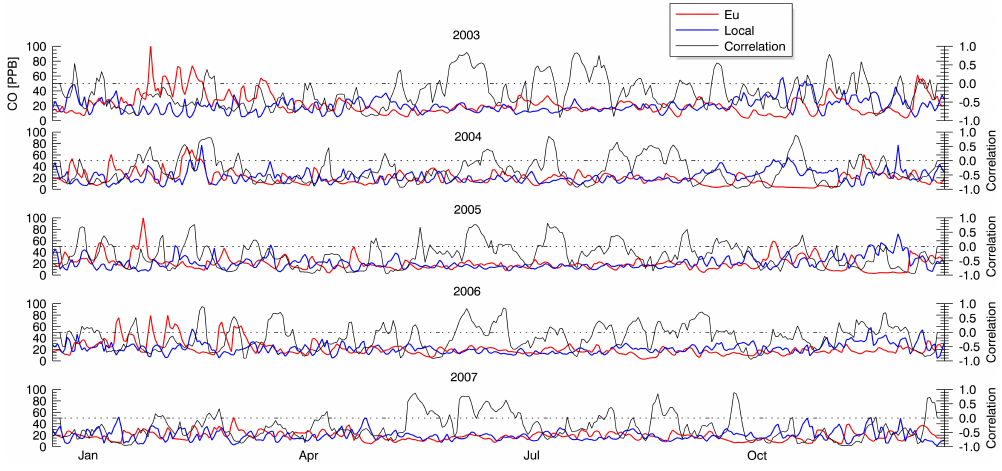
Fig. 12. A comparison between the contribution of European emissions to local CO concentrations (blue) and the contribution of local emissions to local CO concentrations (black). The European contribution is comparable to the local contribution, and they are generally negatively